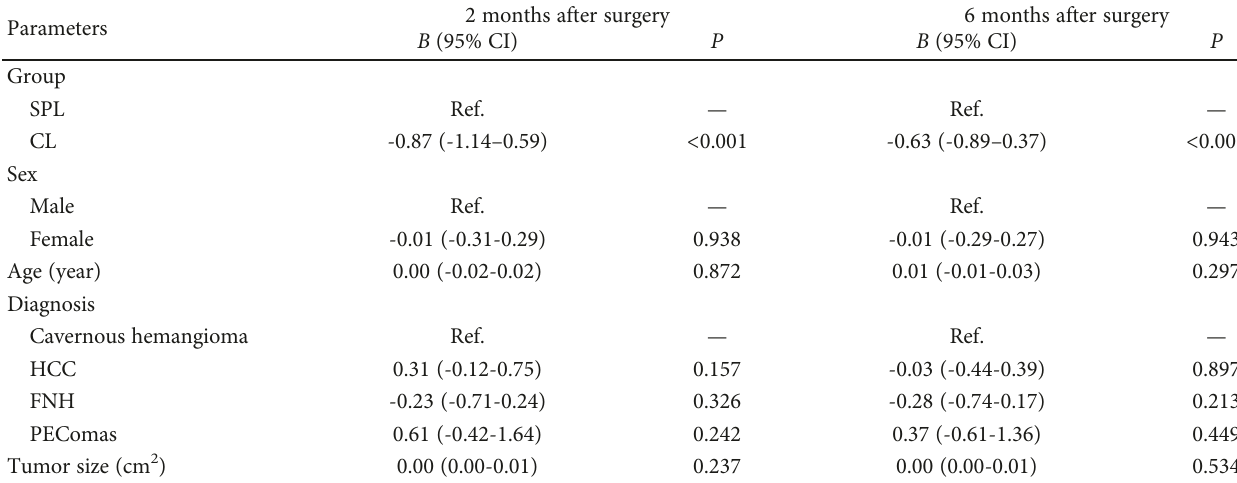
The multivariate linear regression model was adjusted for the demographic and clinical characteristics as well as the independent variables with signi fi cant di ff erence between the SPL and CL groups. To eliminate the e ff ect of the learning curve for SPL, operative time was included as a confounding factor into the multivariate linear regression model. B =regression coe ffi cient; SPL= single-port laparoscopic hepatectomy; CL =conventional laparoscopic hepatectomy; FNH= focal nodular hyperplasia; HCC= hepatocellular carcinoma; PEComas=perivascular epithelioid cell